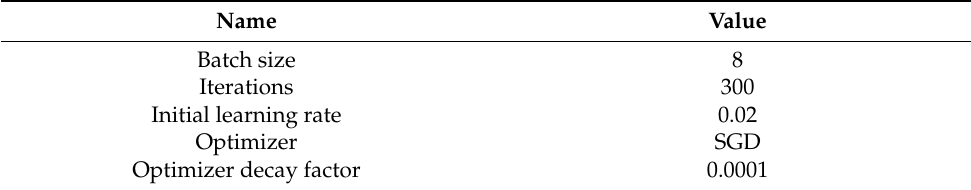
Table 2. Hyper parameter settings of